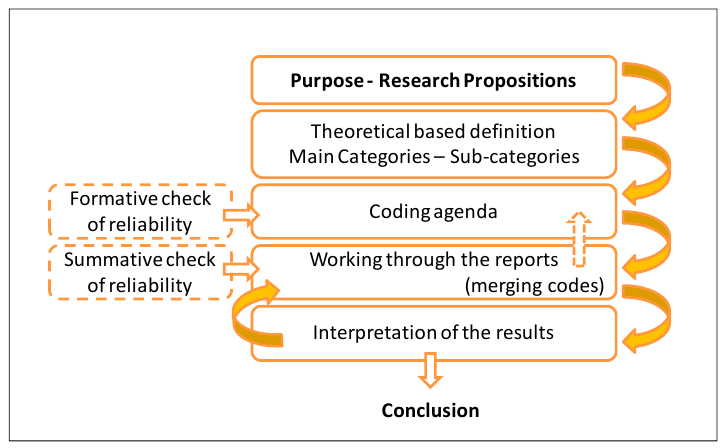
Figure 1. Deductive step model ( Source: Own work ).